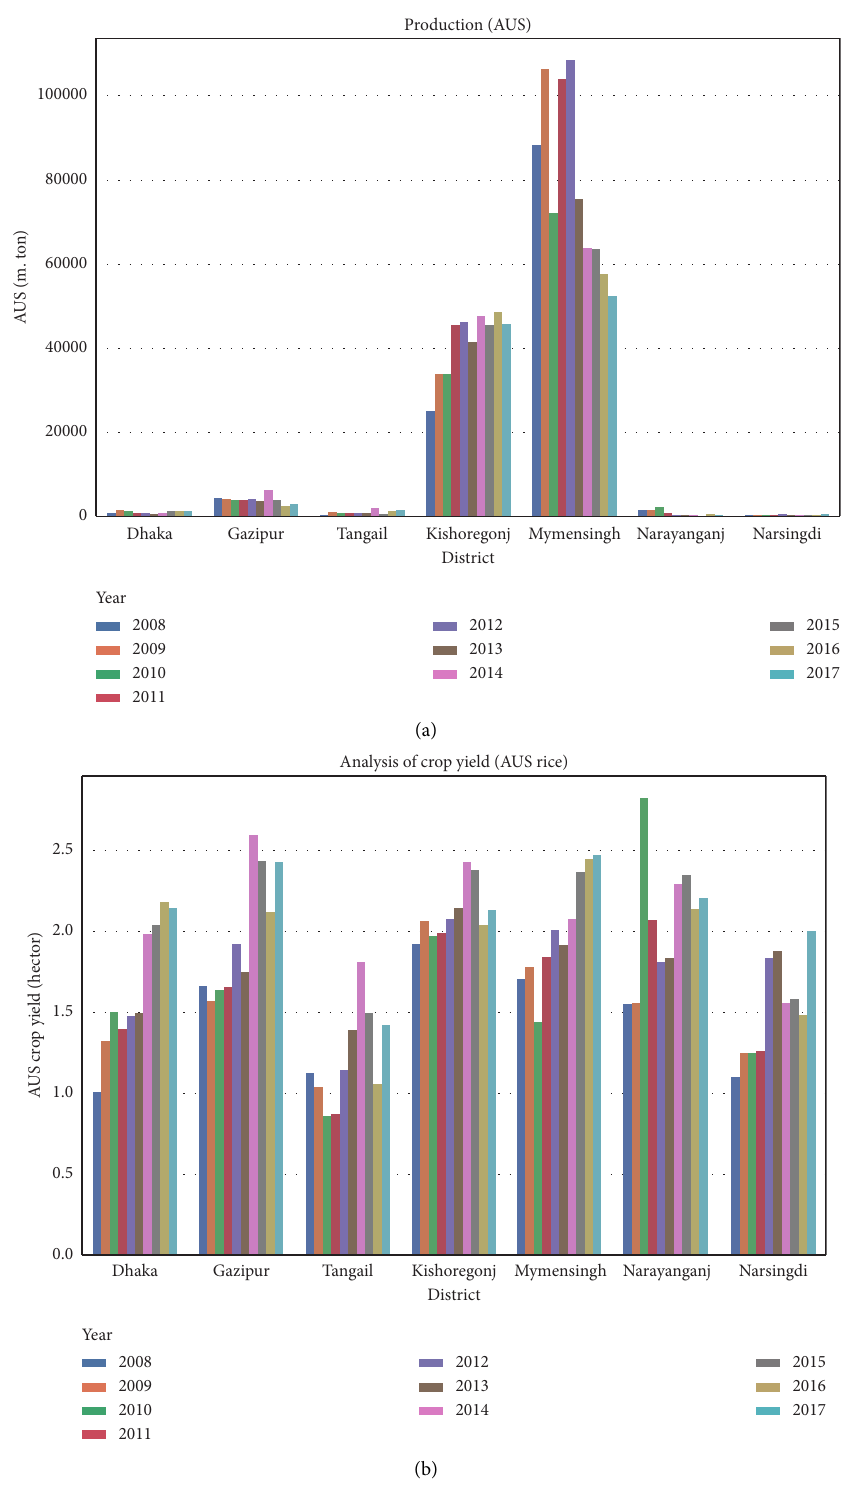
Figure 5: Data analysis of Aus rice. (a) Crop production for Aus rice. (b) Crop yield for Aus